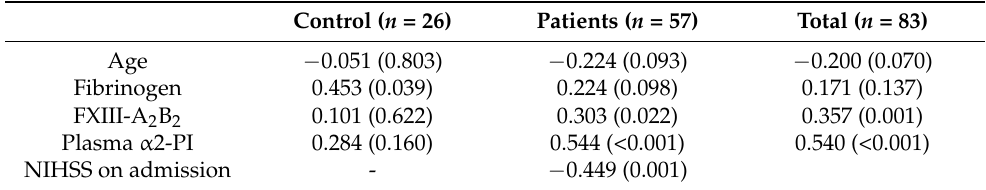
Table 2. Correlation of different parameters with the extent of α 2-PI incorporation into fibrin